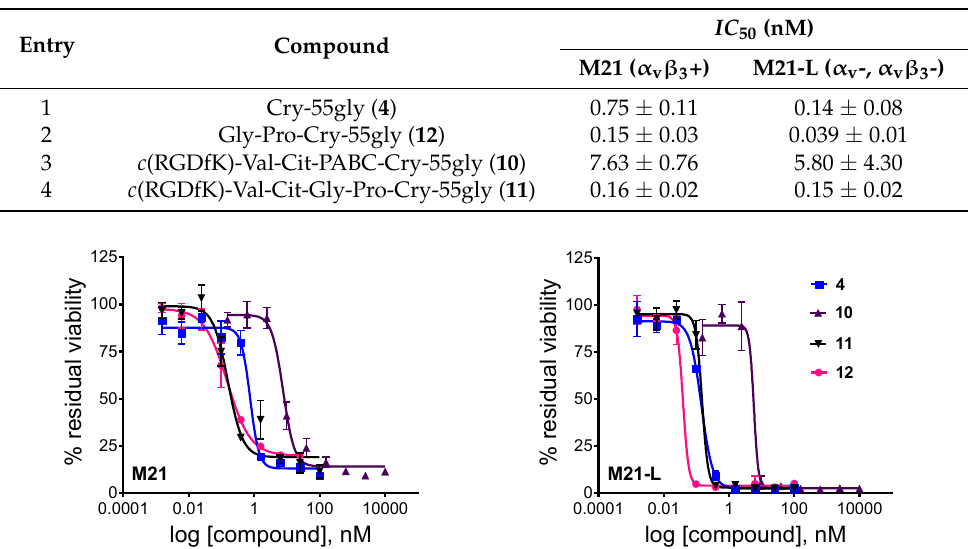
Table 1. Cytotoxic potencies of cryptophycin-55 glycinate ( 4 ), drug-containing metabolite 12 , and bioconjugates 10 and 11 against M21 and M21-L human melanoma cells.